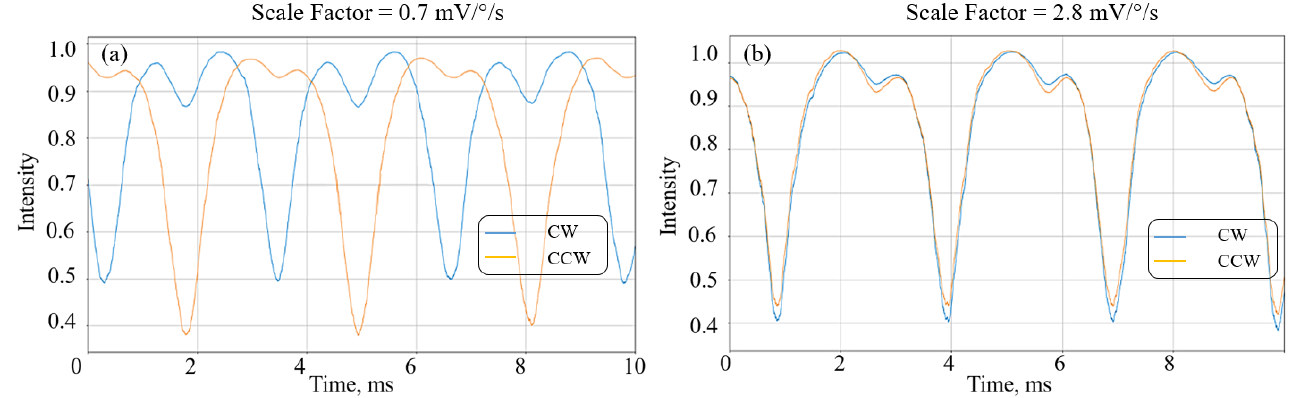
Figure 8. Resonant structures; induced birefringence is taken into account in (a) polarization mis- matching and (b) matched polarization.